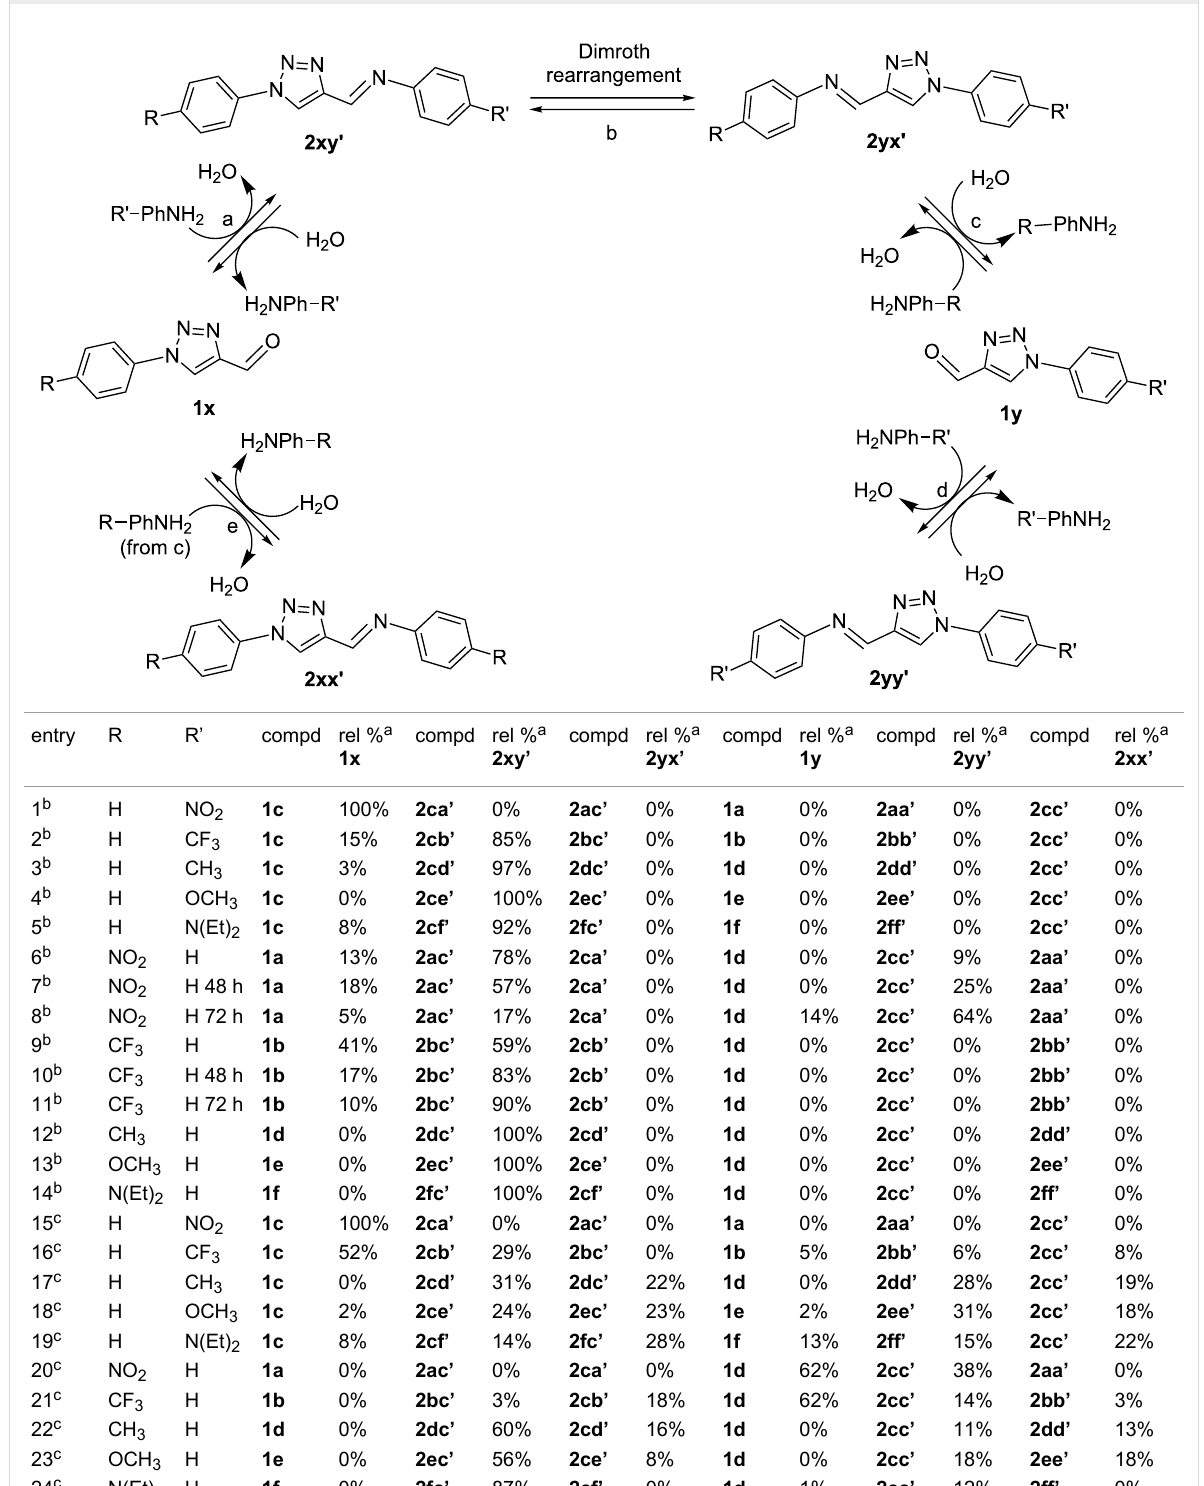
Table 2: Evaluation of unsymmetrical condensation